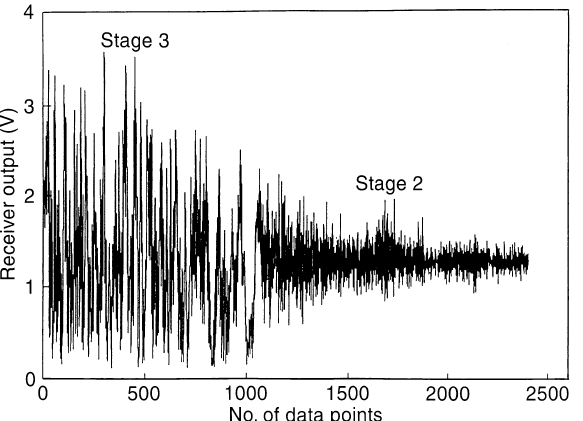
Fig. 6. Shows the weakening of the plasma bubble induced scintillation, where, there is a reversal of the trend, namely, strong stage 3 scintillations are followed by less intense quasiperiodic stage 2 scintillations. This is reverse of the trend depicted in Fig. 1